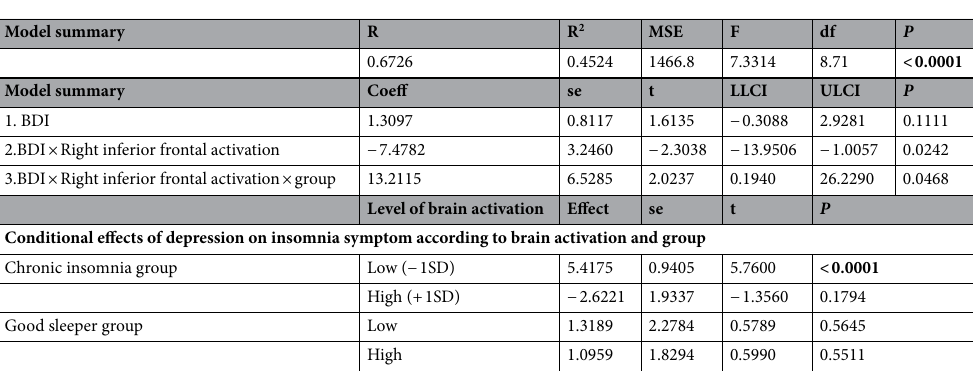
Table 3. Correlation coefficients and 95% confidence intervals obtained via moderated moderation analysis of factors predicting sleep latency based on sleep diaries. Model 1: main effects of BDI. Model 2: interaction of BDI and activity of right inferior frontal region. Model 3: three-way interaction of BDI, activity of right inferior frontal region, and group (CID patients and GS). LLCI lower level confidence interval, ULCI upper level confidence interval, BDI beck depression inventory. Significant values are in